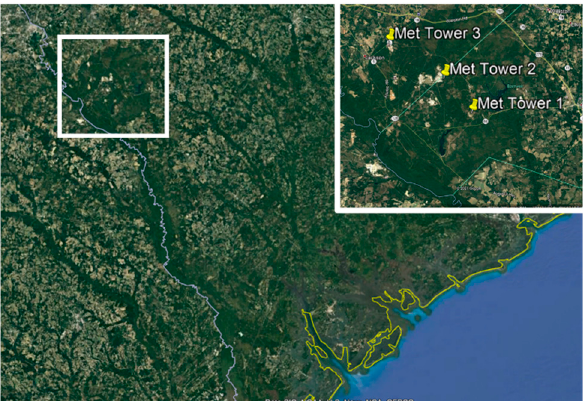
Figure 2. Map of the geographical region between the South Carolina coast and the SRS. The inset in the upper-right shows the locations of MT1, MT2 and MT3 on the SRS.